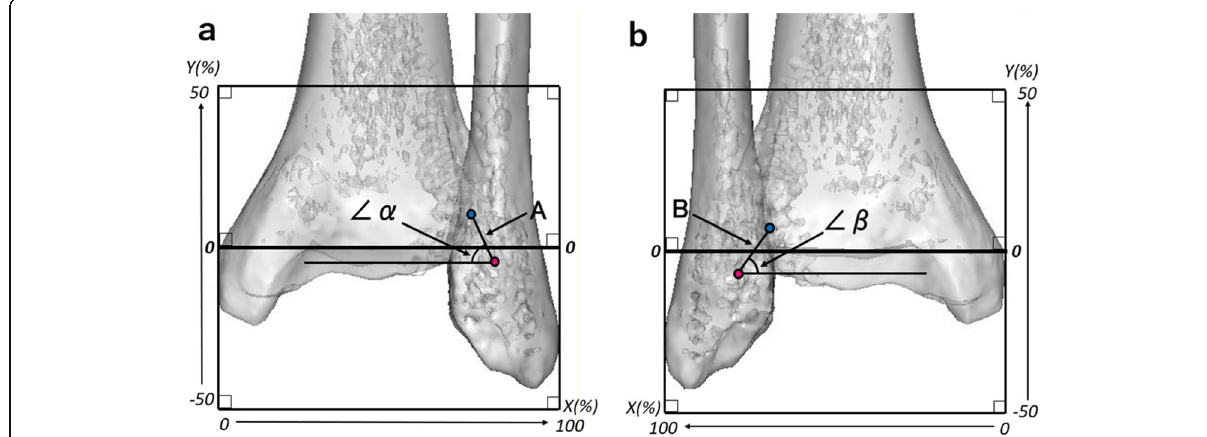
Fig. 1 Measurements of the angles and lengths of the ligaments and original coordinate planes with squares. Distances between the center points of the tibial and fibular insertion sites of the ( a ) anterior inferior tibiofibular ligament (AITFL) and ( b ) posterior inferior tibiofibular ligament (PITFL). The angles were formed between a horizontal line and the line between the center points of the tibial and fibular insertions of the AITFL ( α ) and PITFL ( β ). The maximum medial – lateral distance between the medial tibial cortical line and most of the lateral fibular cortical line in the true anterior view of the three-dimensional images was used as a standard (100%), and coordinate grids fitting the medial and lateral condyles on the three-dimensional images were created. The x-axis was defined as the middle of the coordinate grid (the horizontal line of the tibial plafond). The y-axis was defined as the medial perpendicular line on the grids. The origin of the coordinate axes was the point of intersection between the y-axis and the horizontal line of the tibial